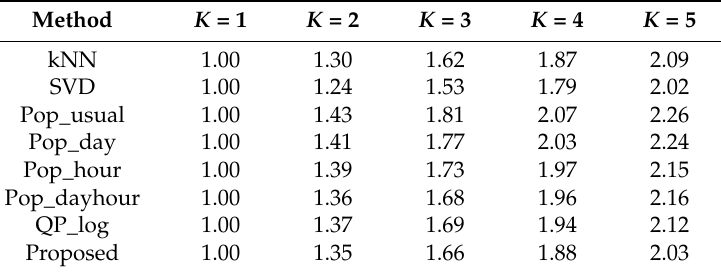
Table 2. Average rank of TV recommender